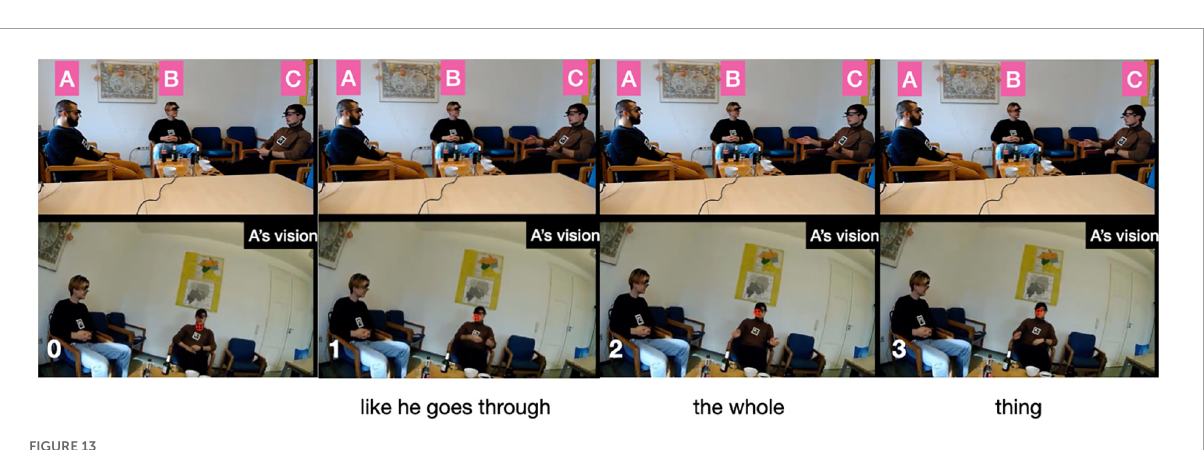
FIGURE13 Storyteller C’s gesture during “like he goes through the whole